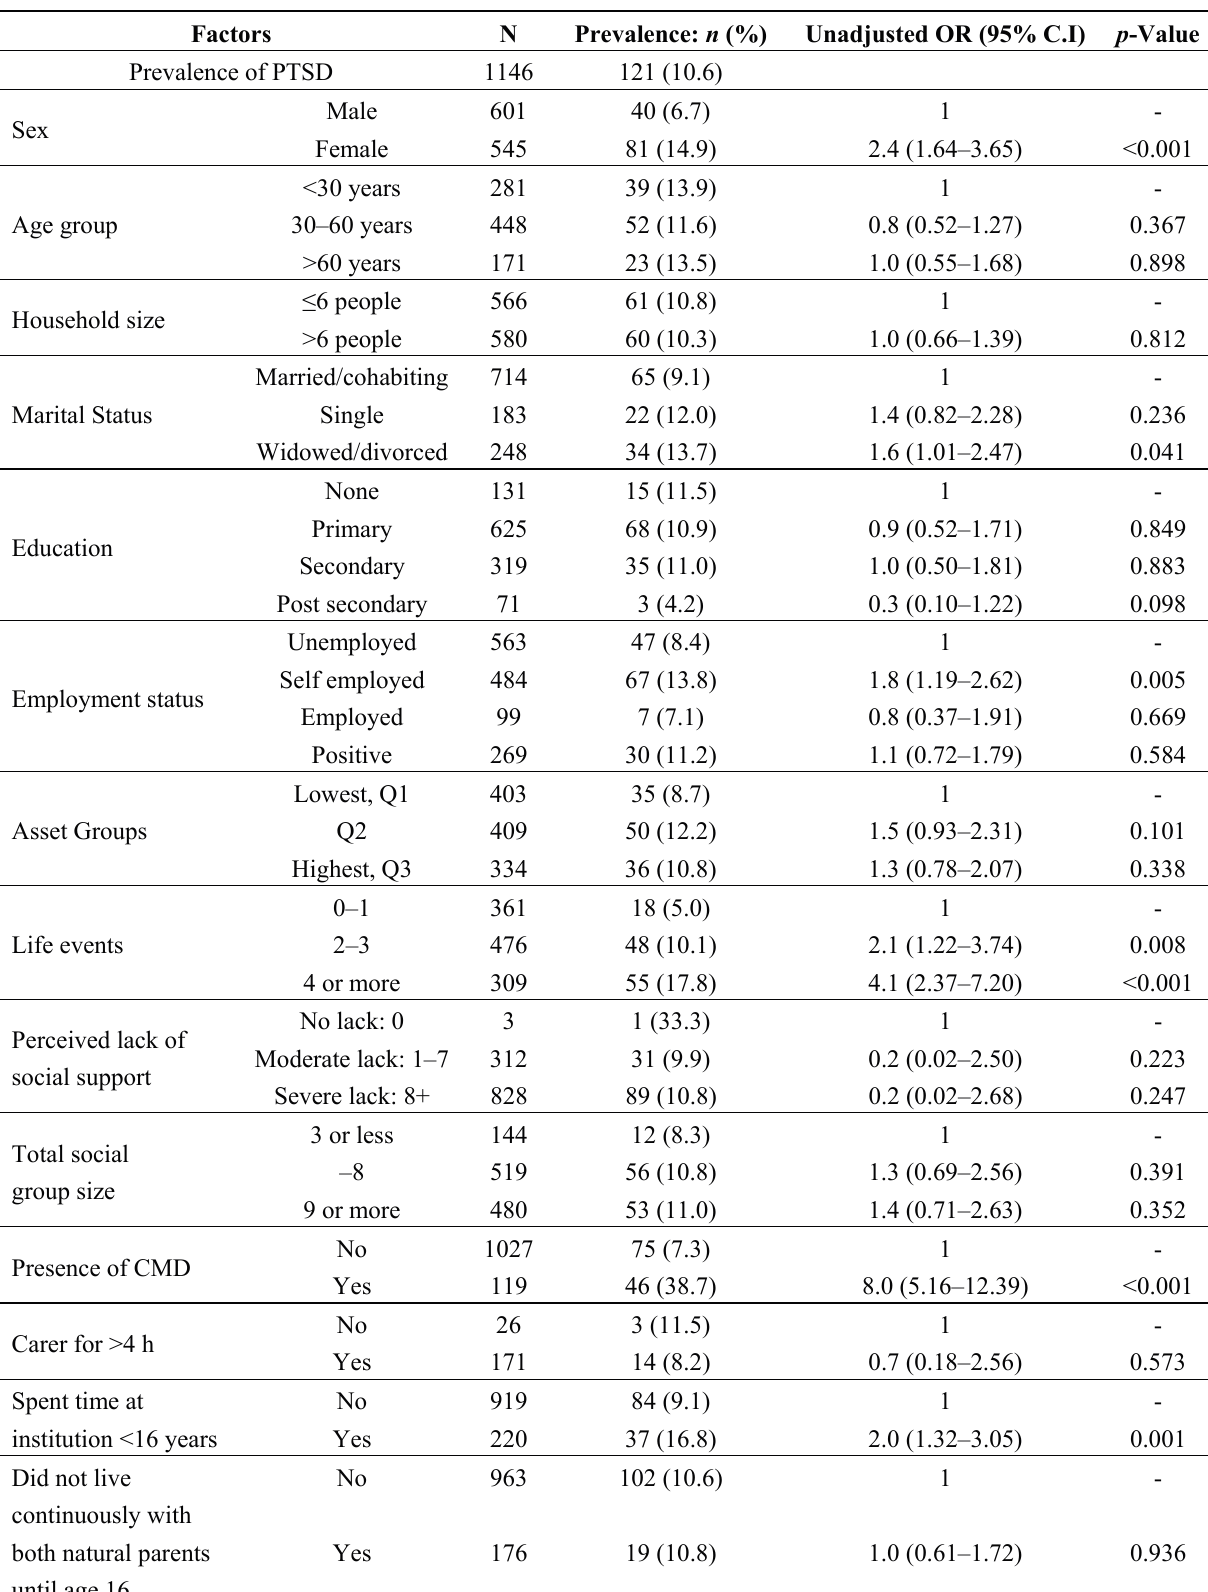
Table 2. Prevalence of probable PTSD over the last one week and its relationship with socio-demographic and health related factors, using univariate analysis (unadjusted odds